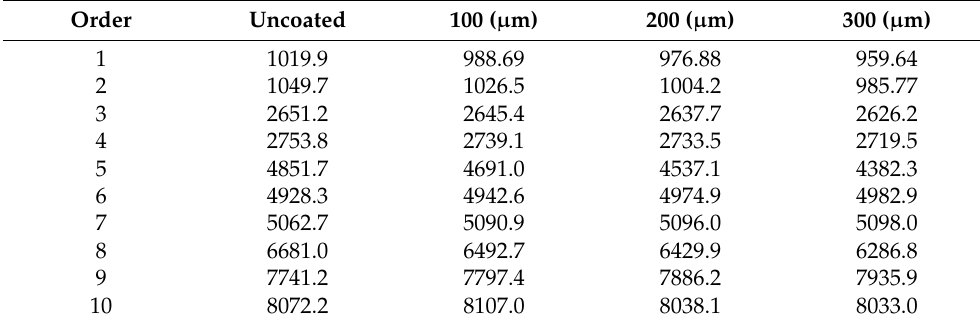
Table 8. Maximum deformation of the main vibration mode of the TA18 titanium alloy straight aviation hydraulic pipe coated with the YSZ coating at different coating thicknesses